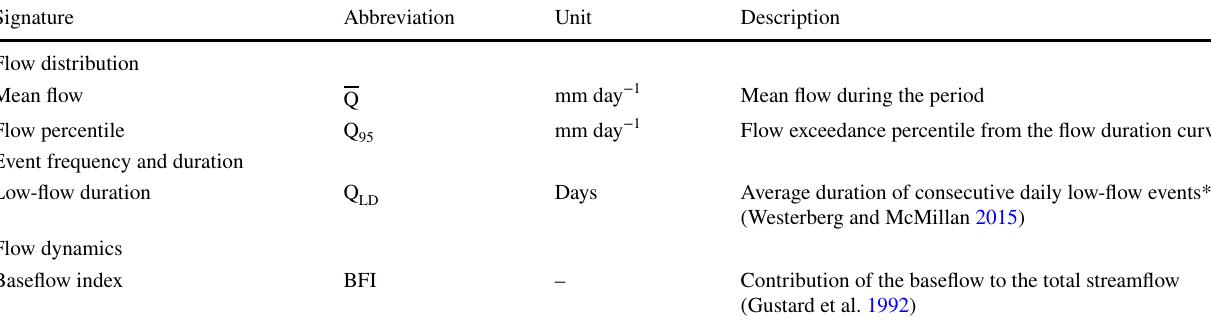
* In Westerbeg and McMillan (2015), low-flow events are days when the flow is lower than 0.2* Q . Here, low-flow events are considered days when the flow is lower than Q 80 , i.e., the 80th percentile of the